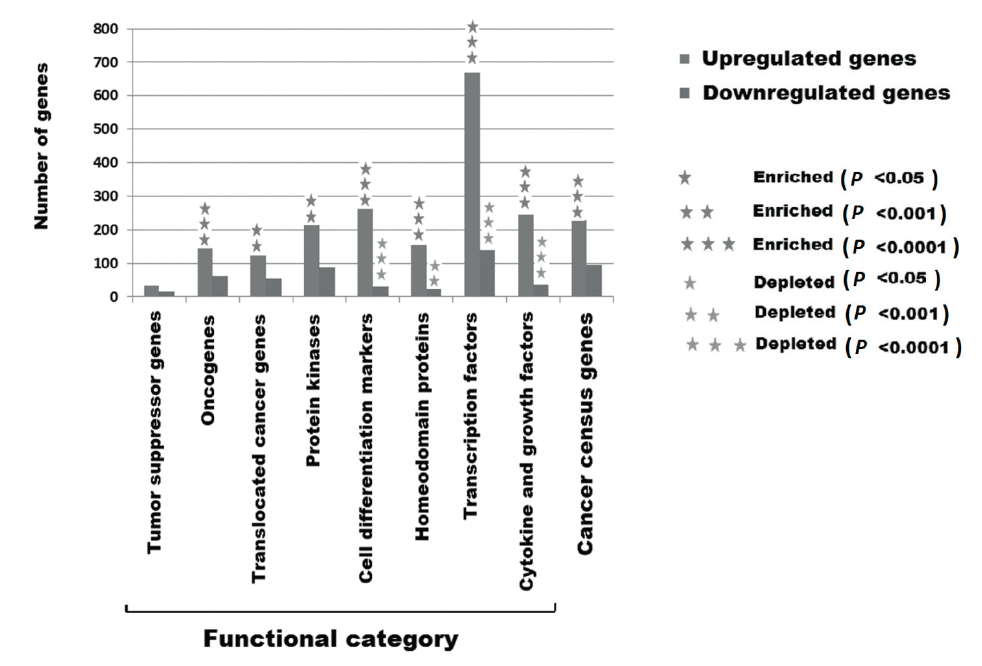
Fig. 2. Functional annotations for all astrocytoma genes. Enrichment of tumor suppressor genes, oncogenes, translocated cancer genes, protein kinases, cell differentiation markers, homeodomain proteins, transcription factors and cytokine and growth factors; and Cancer Census Genes in differentially expressed genes in astrocytoma. Significant enrichment of genes in a category within a tumor type is represented by ’*’ ( P < 0.05), ’**’ ( P < 0.01) and ’***’ ( P < 0.001) (Fisher’s exact